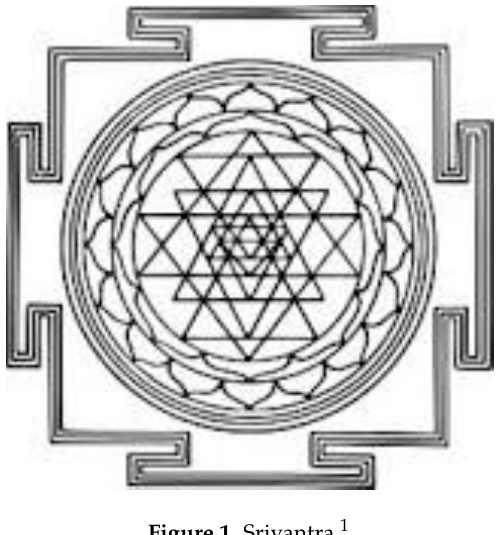
Figure 1. Sriyantr a. 1 Figure 1. Sriyantra.